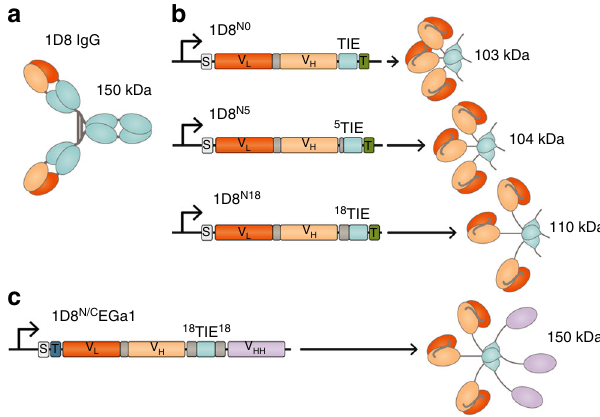
Fig. 1 Schematic diagrams of 4-1BB-agonistic trimerbodies. Protein structure of the anti-4-1BB IgG ( a ) and the gene layout (left) and protein structure (right) of monospeci fi c ( b ) and bispeci fi c trimerbodies ( c ). The variable regions derived from 1D8 antibody are represented in orange, the anti-EGFR V HH EGa1 in violet, the structural domains in light blue, and the linker regions in gray. The 1D8 scFv-based N-terminal trimerbodies ’ (1D8 N ) gene constructs ( b ) contain a signal peptide from oncostatin M (white box) and the 1D8 scFv gene (V L -V H ) connected directly or through fl exible linkers to the mouse TIE XVIII domain. In the bispeci fi c 1D8 N/C EGa1 trimerbody ( c ), the anti-human EGFR V HH EGa1 is fused to the C-terminus of 1D8 N18 through a fl exible linker. Arrows indicate the direction of transcription. His6-myc tag (green box) and FLAG-strep tags (dark